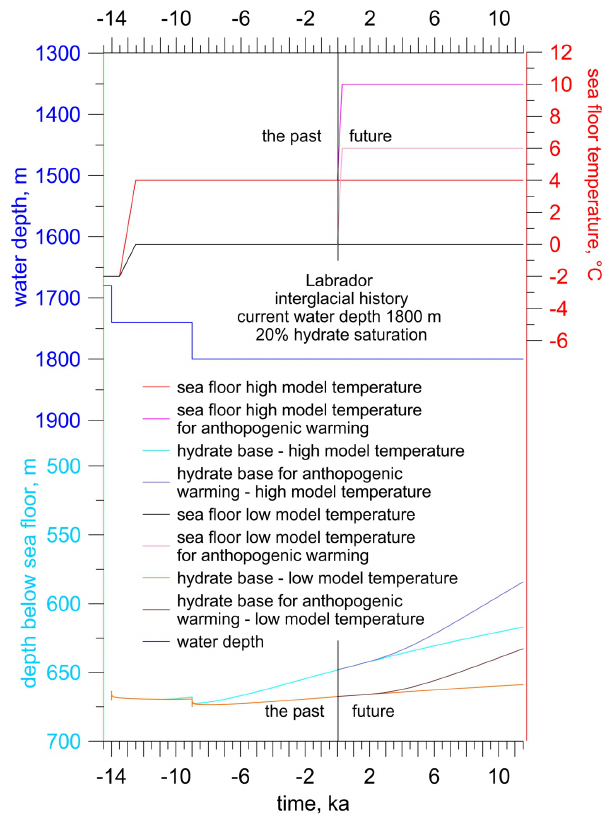
Figure 12. Labrador Sea GH history models for current a 1800 m water